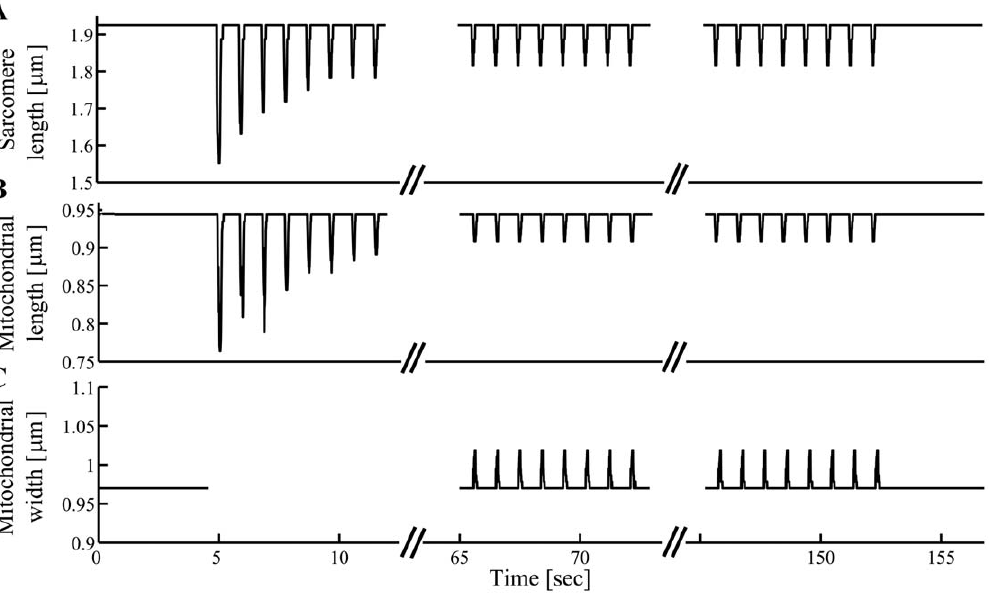
Figure 4. Deformation of mitochondria in response to sarcomere contraction. (A) Sarcomere length and (B) mitochondrial length calculated from frequency domain analysis along length-x axis during electrical stimulation (1 Hz). (C) Mitochondrial width calculated from frequency domain analysis along width-y axis during electrical stimulation (1 Hz).